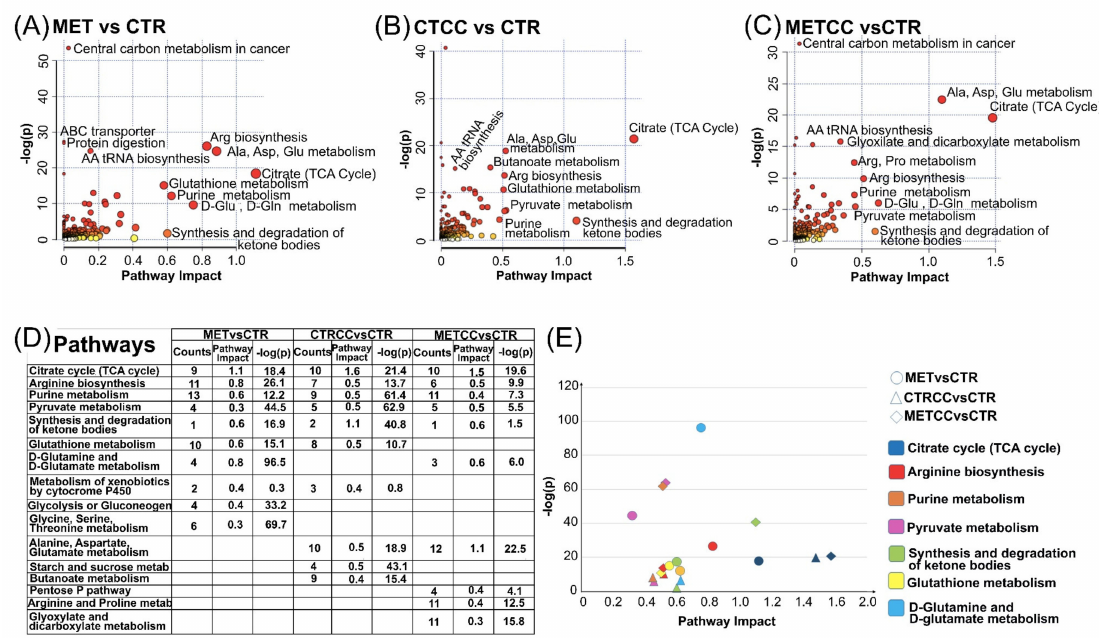
Figure 5. Integration of metabolomics and proteomics analysis. ( A ) Metabolic and proteomic pathways mostly a ff ected in MET versus CTR. ( B ) Metabolic and Proteomic pathways mostly a ff ected in CTRCC versus CTR. ( C ) Metabolic and Proteomic pathways mostly a ff ected in METCC versus CTR. The scatter plots show a summary of the joint evidence from enrichment analysis ( p -values) and topology analysis (pathway impact). Dots size and color (white to red) are proportional to the numbers of genes and compounds present in a pathway. ( E ) List of the 10 more significant pathways in each of the three comparisons. ( E ) Scatter plot of the common pathways among the list shown in ( D